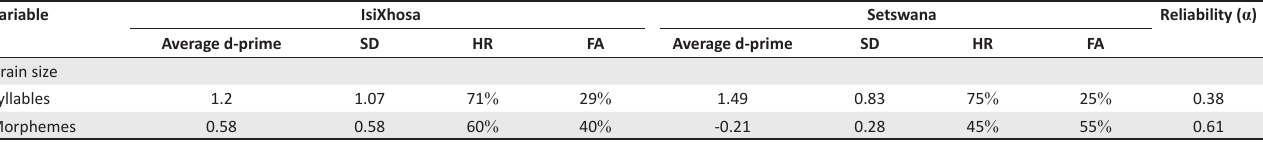
ORF, oral reading fluency. * , Correlation is significant at the 0.01 level. TABLE 7: Decomposition task (d-prime) results for isiXhosa and Setswana learners. Variable